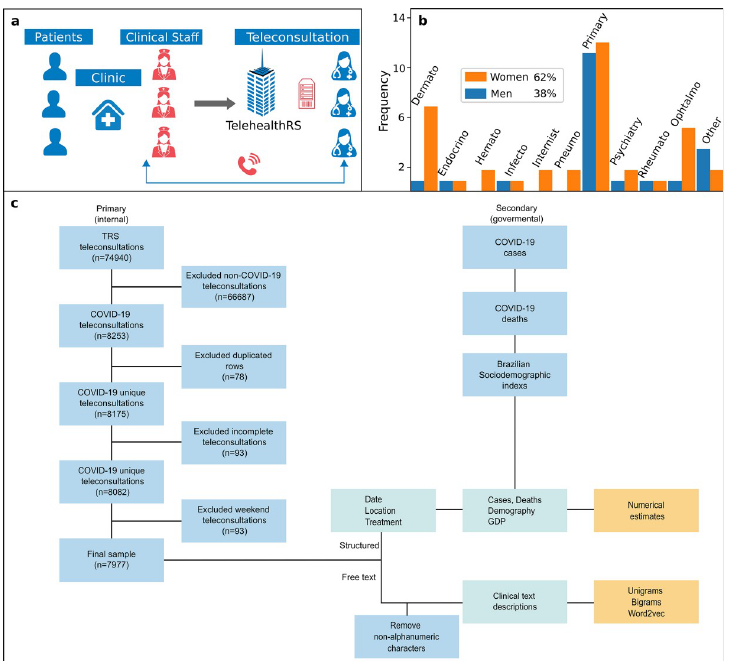
Fig 1. Structure of TRS and the distribution of teleconsultations in Brazil. (a) A flow process to perform teleconsultations at TRS, medical staff from clinical centers contact TRS through a telephone line (0800) that is answered by a physician teleconsultant (b) The frequency of physicians at TRS by specialization and gender (c) The flowchart of the process to retrieve and process the data for this study. The data was retrieved from primary (TRS) sources that passed through a validation process and secondary sources. Finally the free text data was preprocessed and used to estimate frequencies and vector representations and the structured text and secondary sources to plot the rest of the